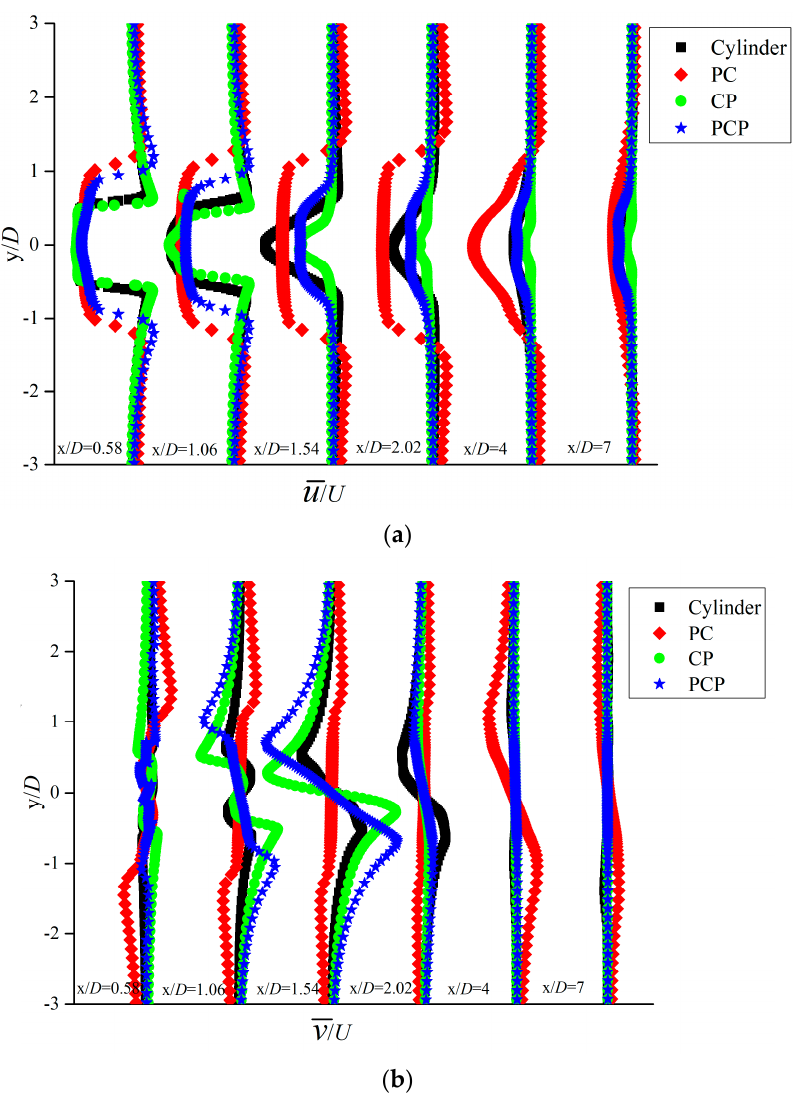
Figure 16. Time-averaged velocity profiles at different locations: ( a ) (cid:3048)̄